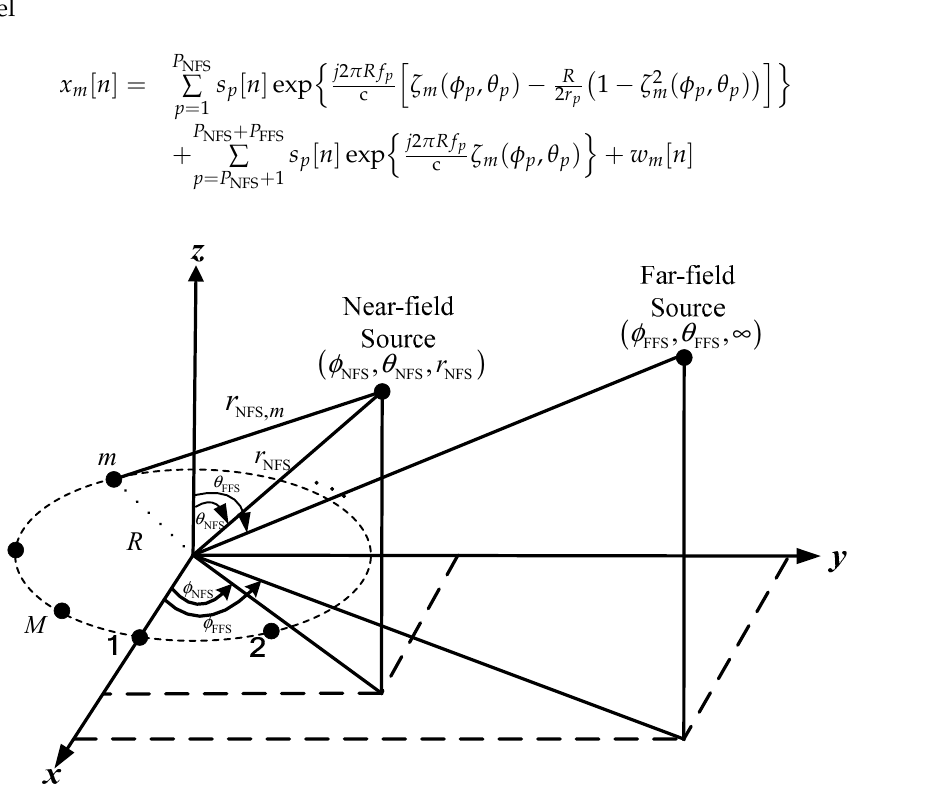
Figure 1. Geometry of a UCA with mixed near-field and far-field sources.